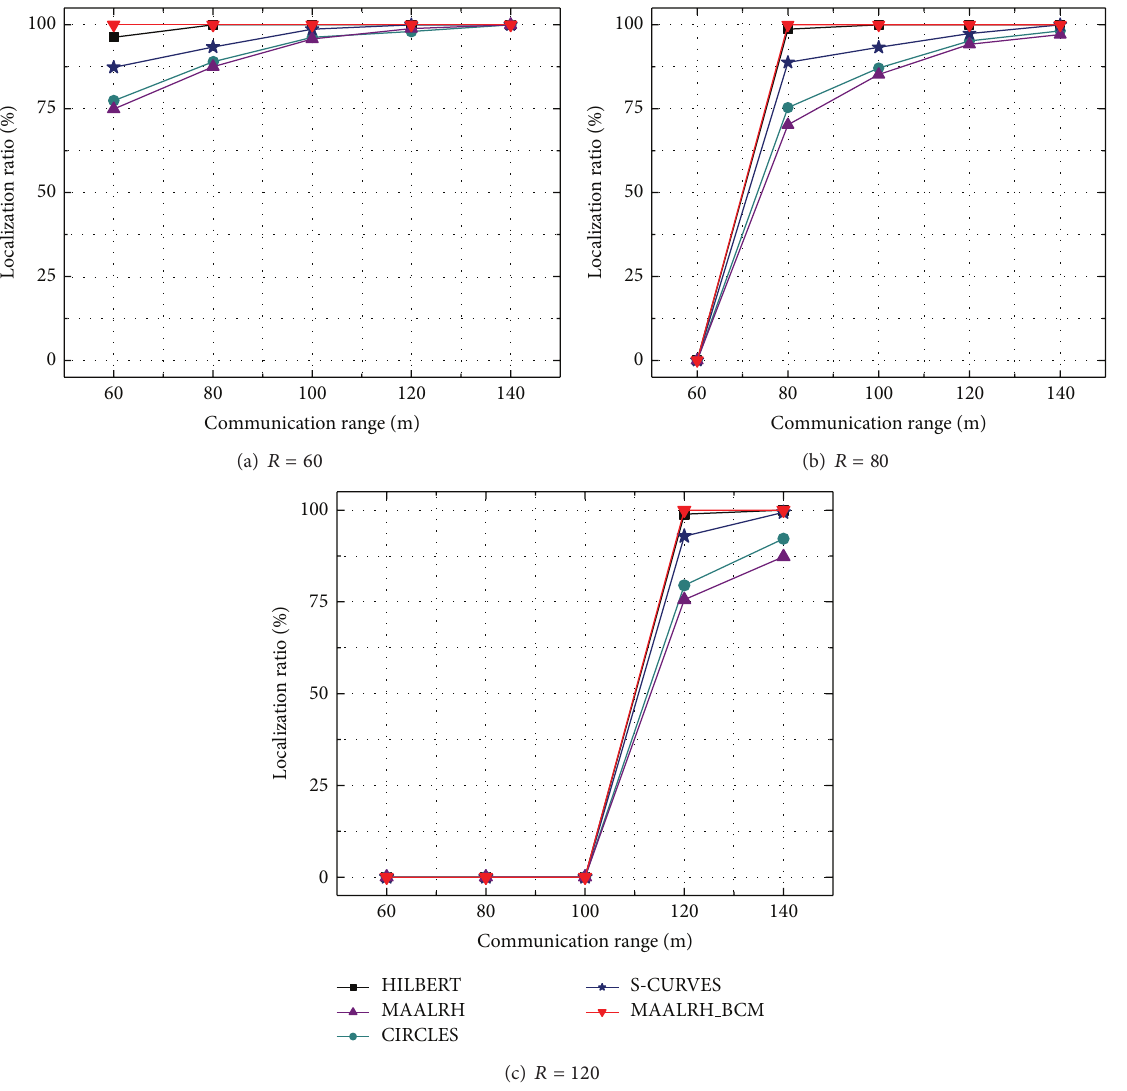
Figure 9: Localization ratio with different